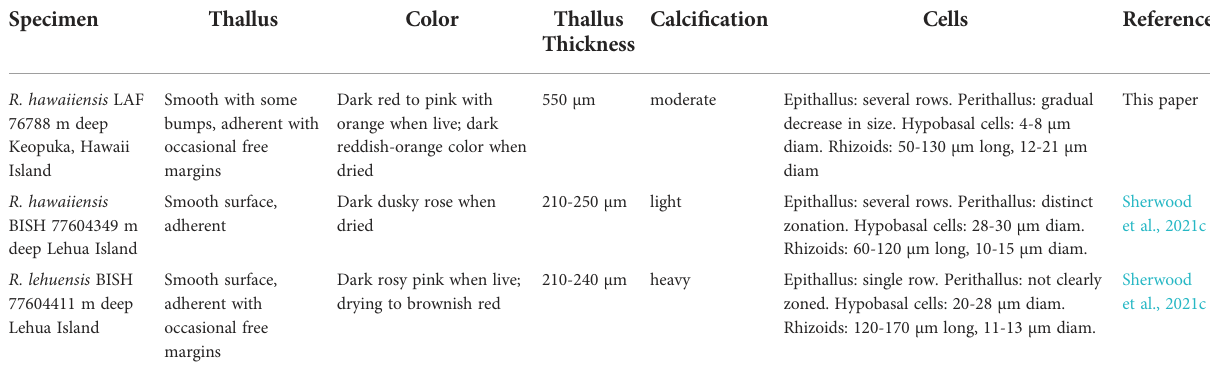
TABLE 1 Morphological comparisons of Hawaiian specimens of Ramicrusta hawaiiensis and R. lehuensis , including thallus thickness, epithelial cells, perithallial cells, presence of pit connections, hypobasal cells, and rhizoid